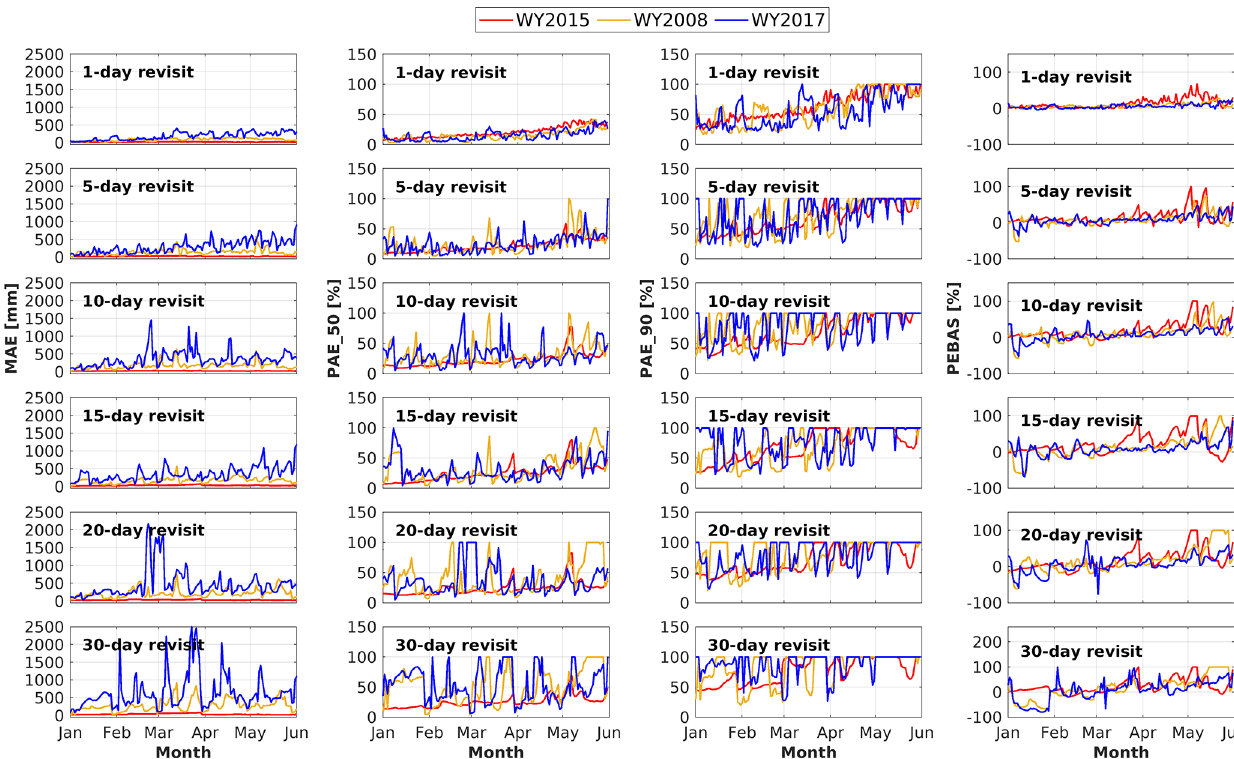
Figure 7. Daily time series of MAE (mm; first column), PAE_50 (%; second column), PAE_90 (%; third column), PEBAS (%; fourth column) from January to June in WY2015 (red line), 2008 (yellow line), and 2017 (blue line) based on revisit intervals of 1- through 30d (rows 1–6,